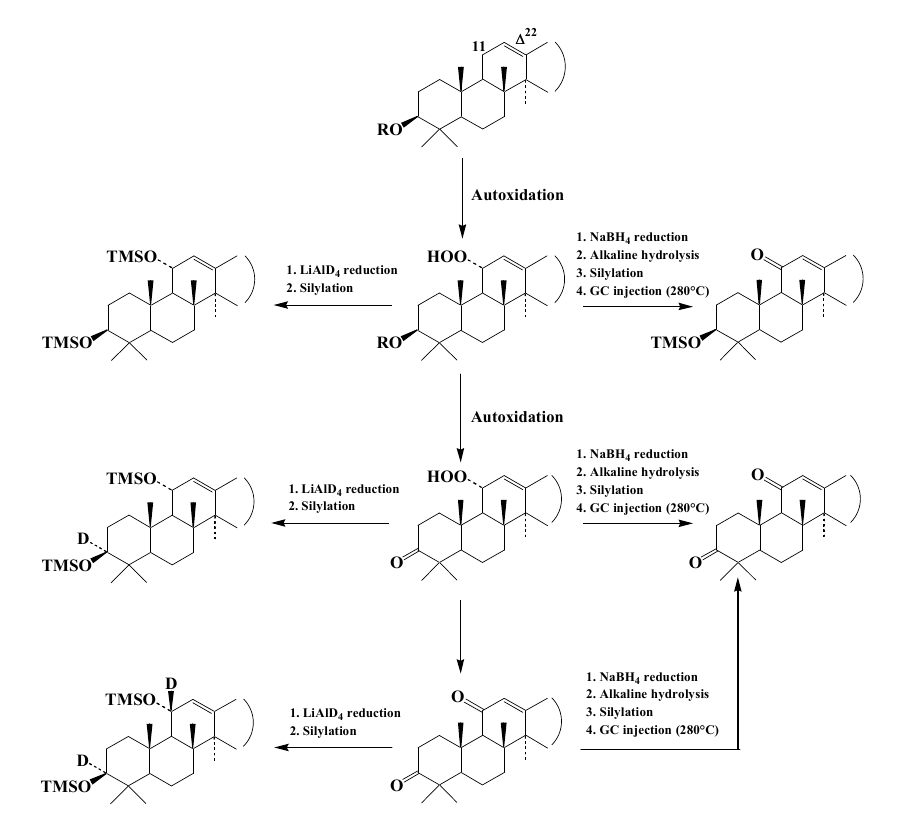
Figure 3. Behaviour of amyrin oxidation products during the different treatments.